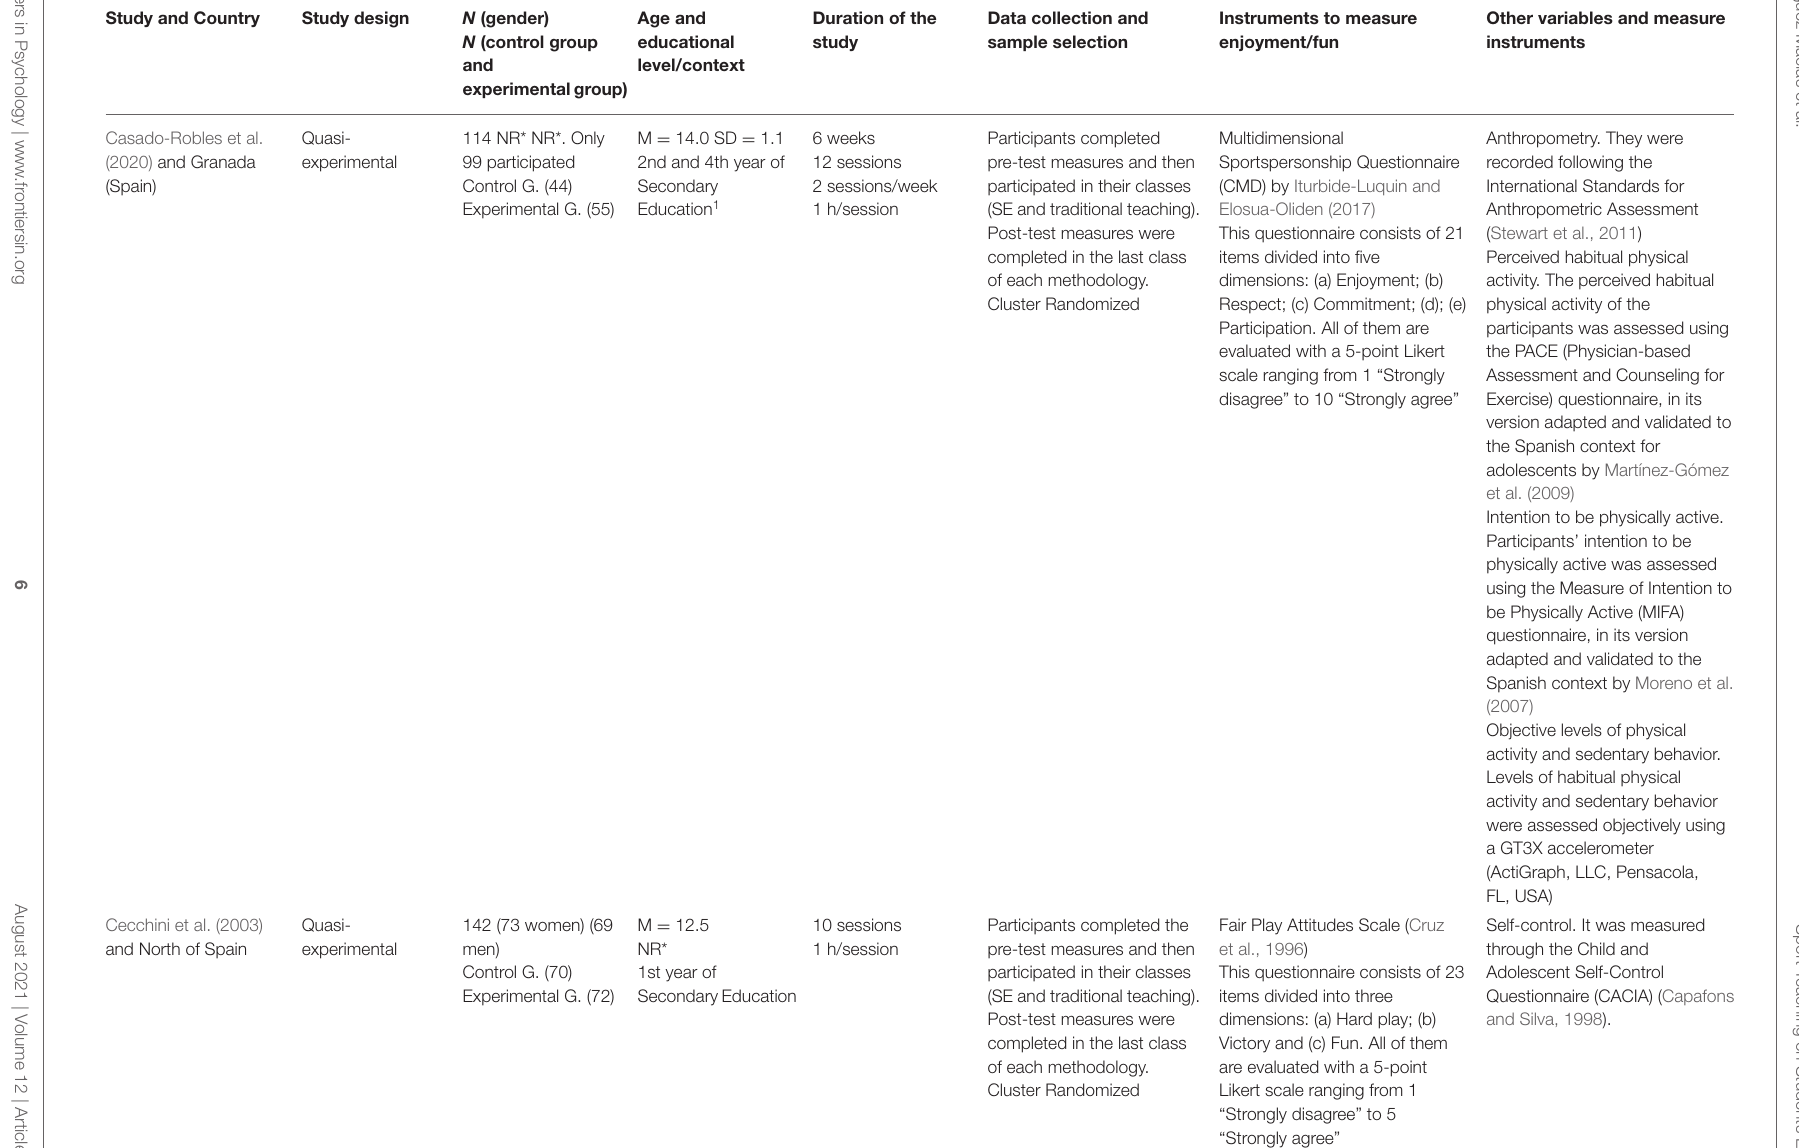
TABLE 2 | Participants’ characteristics, duration, data collection and sample selection, other variables measured, and instrument included in the systematic review and